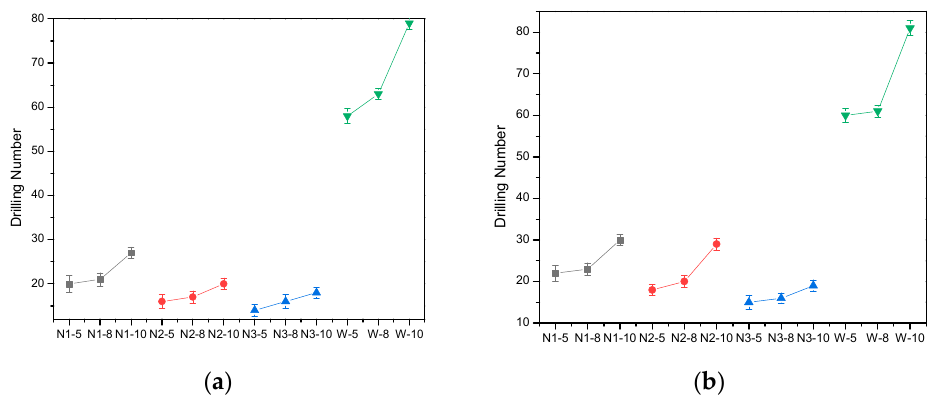
Figure 5. Drilling results of waddings after ( a ) rubbing and ( b ) washing.